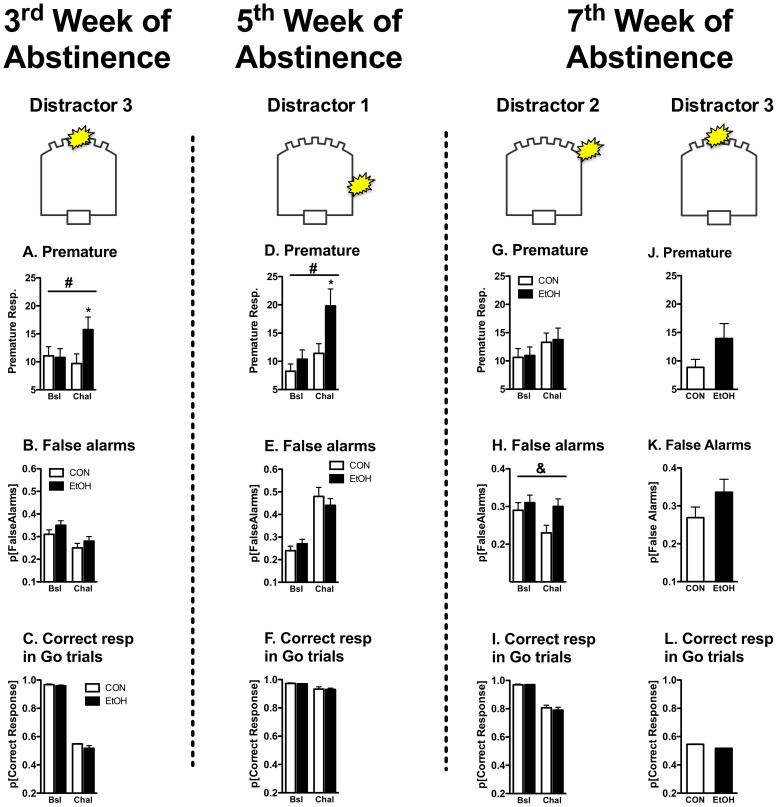
Evaluation of motor impulsivity and impaired behavioral restraint during distractor challenge tests over the course of 7 weeks of abstinence.Challenge tests with visual distractors were performed during the 3rd, 5th and 7th week of abstinence to characterize the temporal profile of altered 5C-CPT performance during protracted EtOH abstinence. Distinct challenge conditions were presented at each abstinence time to minimize habituation to the visual distractor. However, the initially presented distractor condition was presented again at the end of the 7th abstinence week to probe the persistence of initially observed performance disruptions. Effects of each challenge condition were determined by comparing performance during challenge tests (Chal) with baseline performance under familiar conditions (BSL). Data from EtOH-exposed rats (n = 16) are black bars, data from EtOH-naïve controls (n = 17) are white bars. During the 3rd and 5th abstinence week EtOH-exposed rats exhibited increased motor impulsivity (premature responses; panels A & D) without disruption of behavioral restraint (false alarms; panels B & E). EtOH-related increases in motor impulsivity were not evident during the 7th week of abstinence (panel G) (even under the initially employed distractor condition (panel J)) though EtOH-exposed rats exhibited significant impairment in behavioral restraint at this time (panel H). No group differences in response accuracy were evident at any abstinence time (panels C, F, I & L). # denotes significant group x challenge interaction and & denotes significant group main effects (p<0.05; Test vs. BSL ANOVA). * denotes significant group differences determined by Fisher's protected LSD (p<0.05).